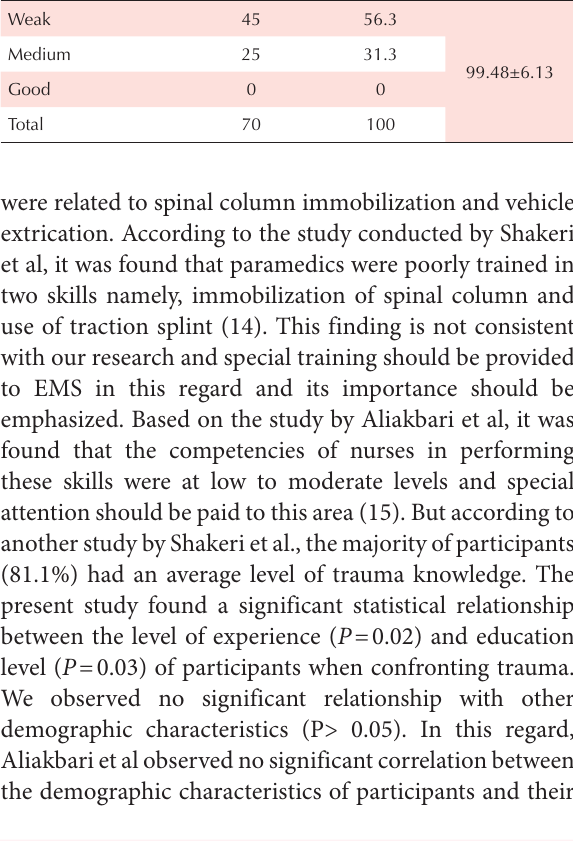
Table 4 . Distribution of the EMS Staff according to the total score of clinical skills Clinical competency